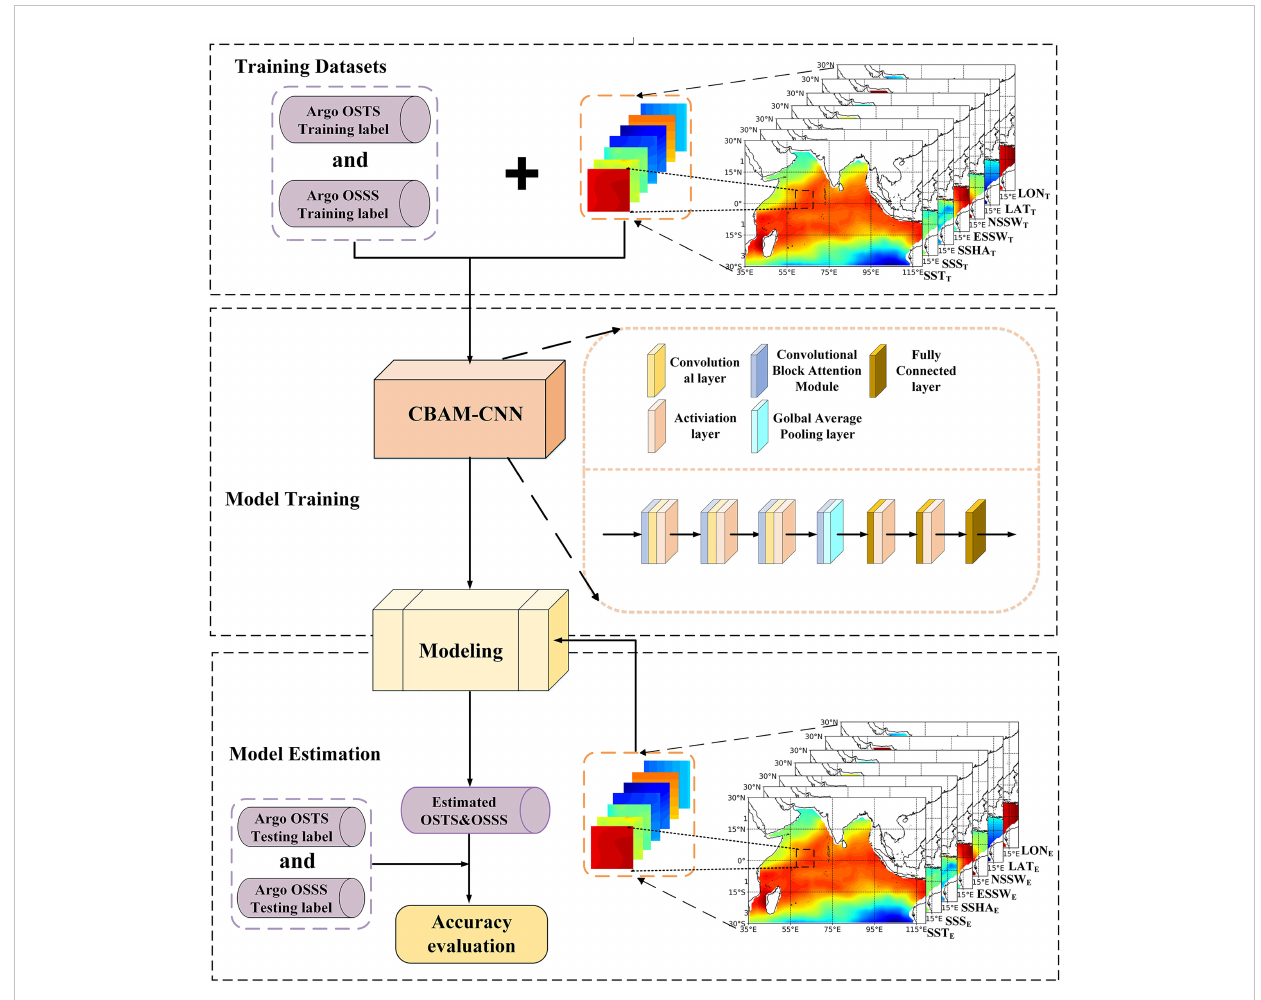
FIGURE 2 Flowchart of the CBAM-CNN model for estimating ocean subsurface thermohaline structure in the tropical Indian